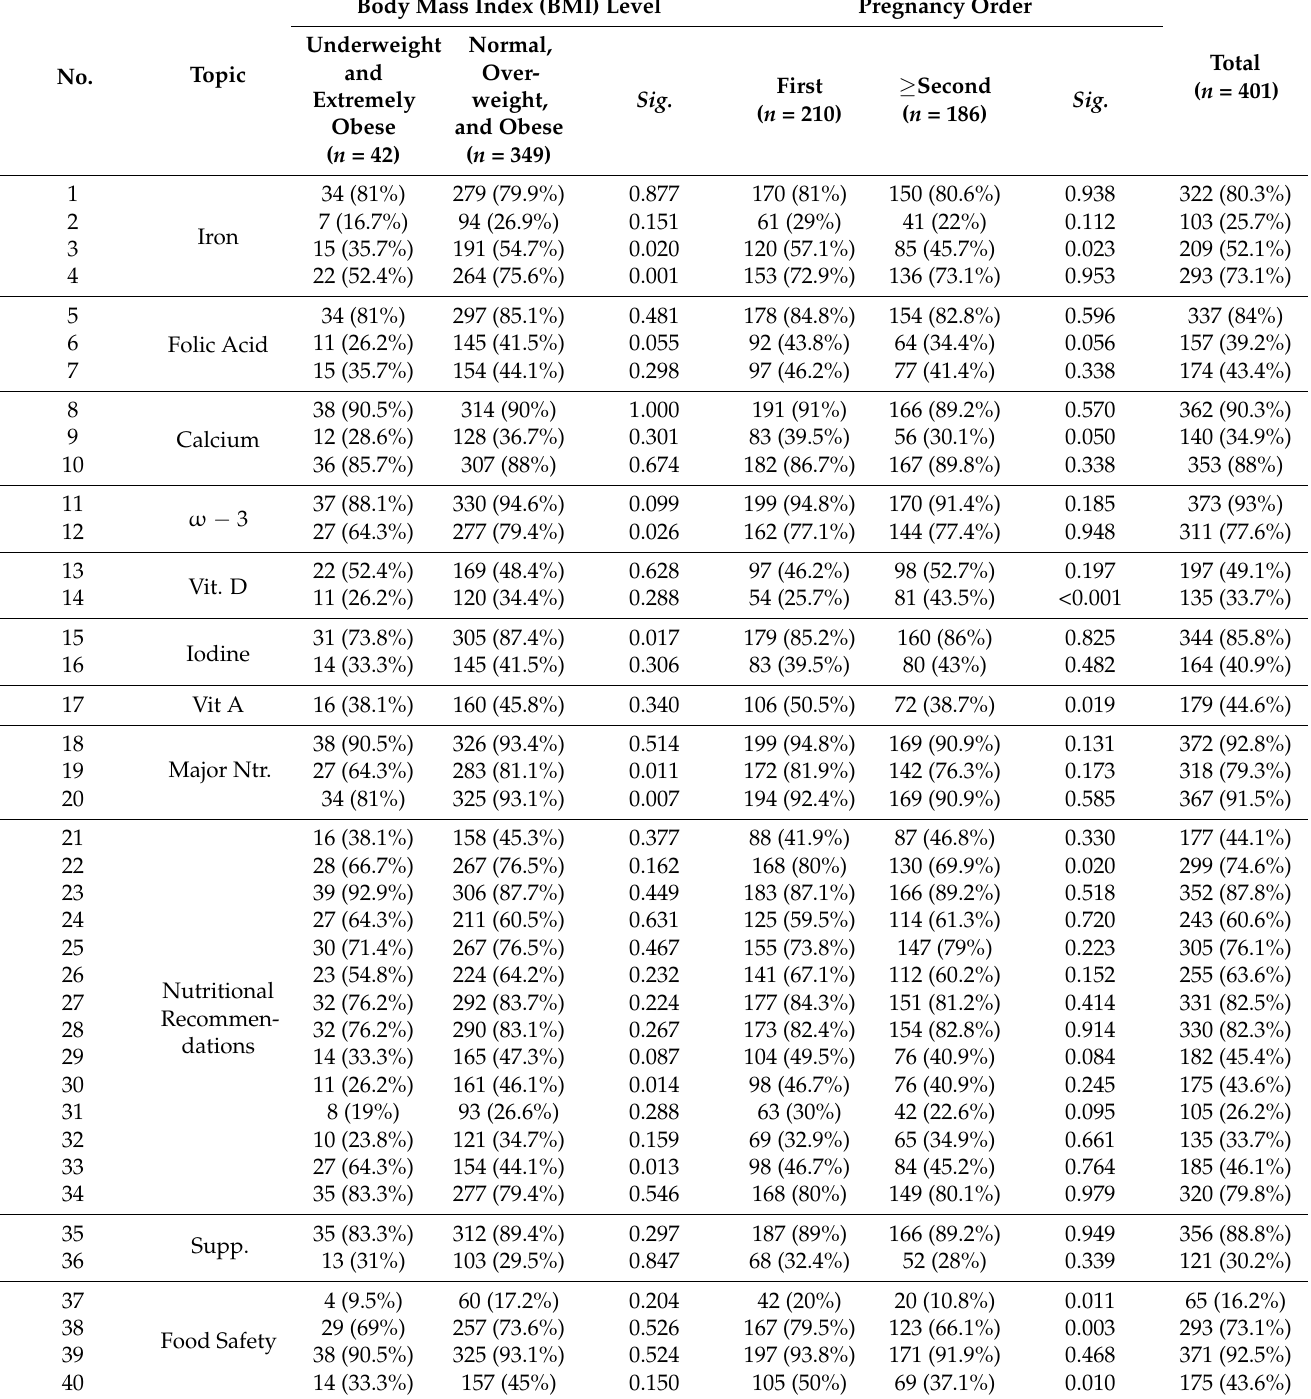
Table 3. Nutritional health knowledge items of pregnant women participating in the nutritional health survey according to BMI and pregnancy order, April–May 2022 ( n =